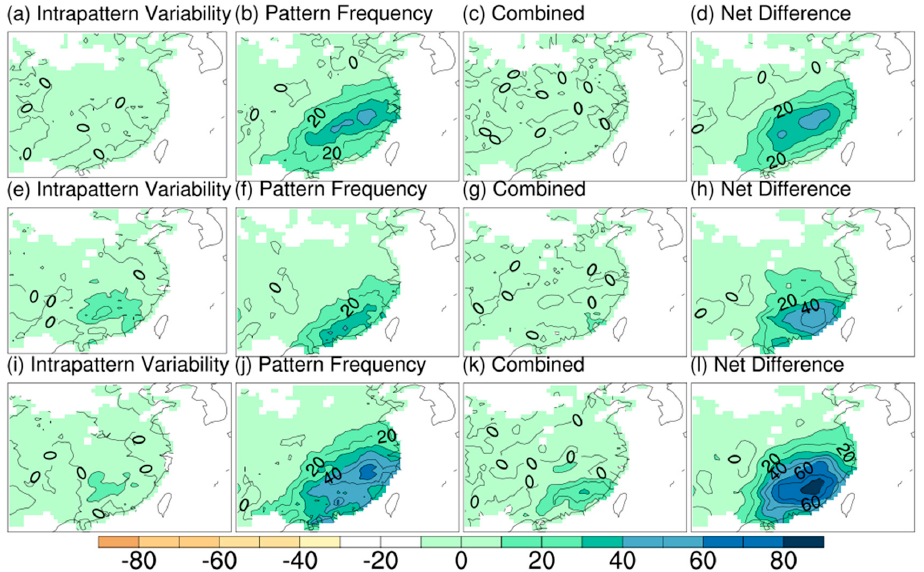
Figure 7. (top row) Differences between December and January. (middle row) Differences between January and February. (bottom row) Differences between December and February. The three columns on the left side of each row are the three difference terms: the intra-pattern variability component, the pattern frequency component, and the combined term. The right side of each row is the total difference.